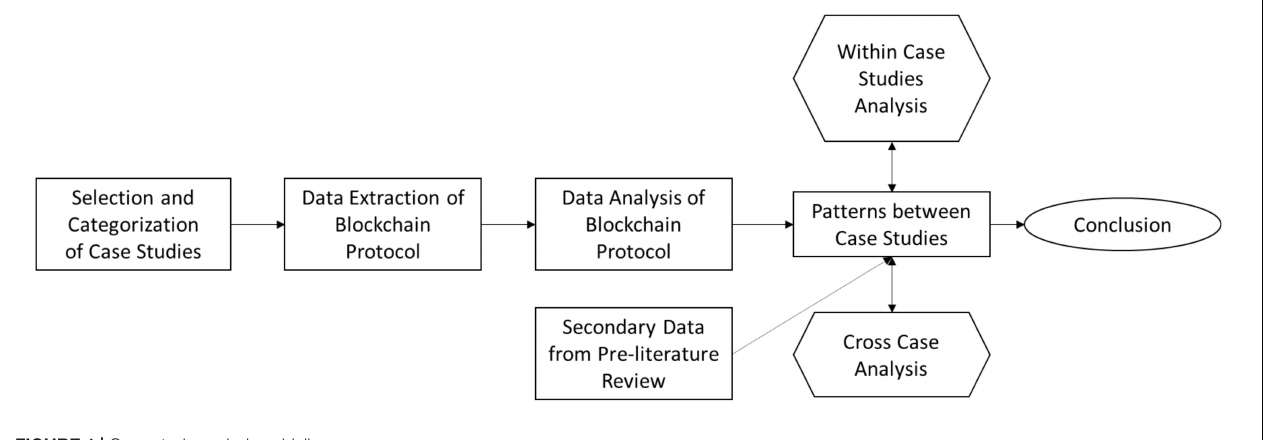
FIGURE 1 | Case study analysis guidelines.